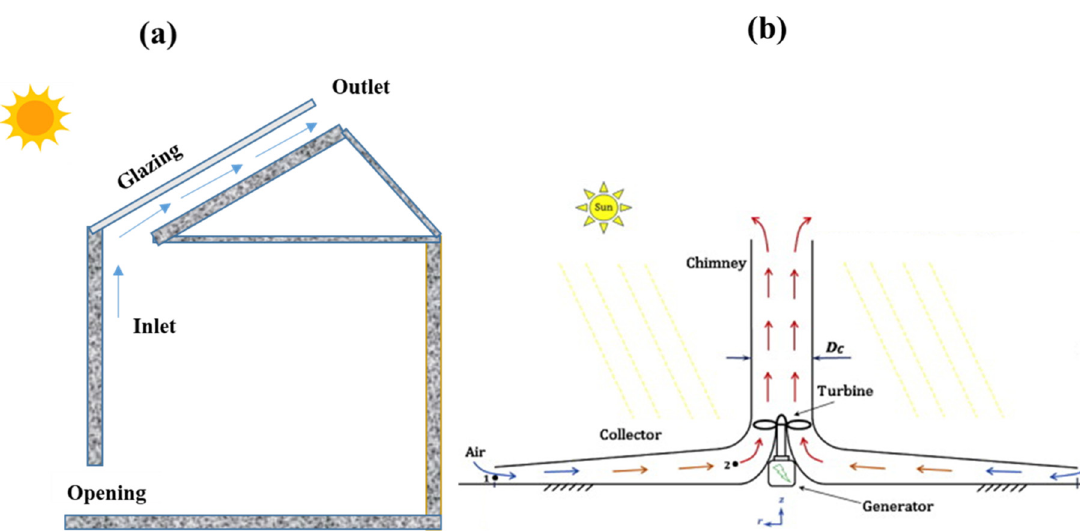
Figure 5. Applications of solar chimney: ( a ) natural ventilation and ( b ) power generation, adapted from [67] with permission No. 5413141175242.